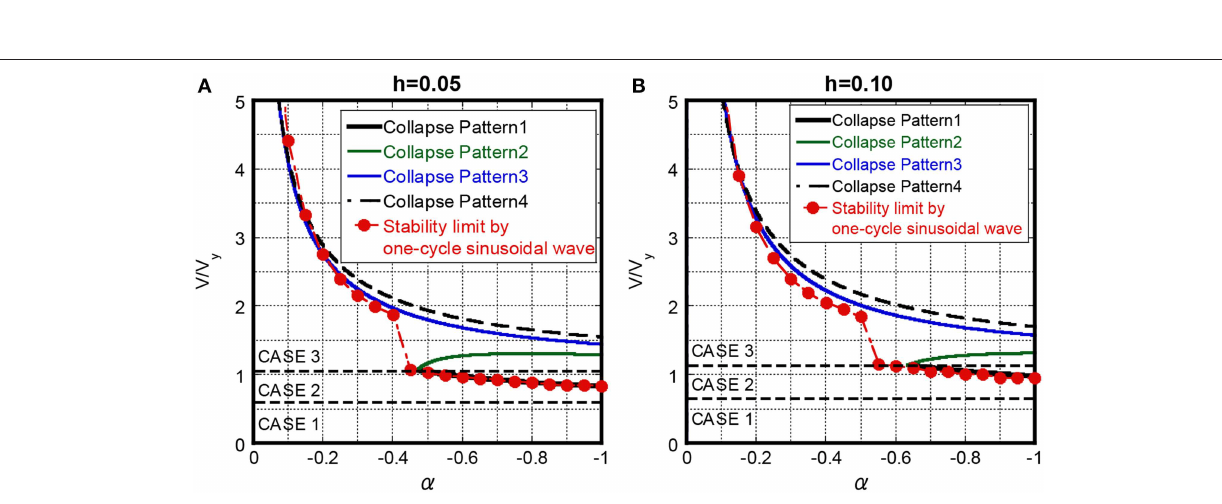
FIGURE 12 | Comparison of proposed collapse-limit input velocity level of critical double impulse and collapse level of one-cycle sinusoidal wave, (A) h (B) h =